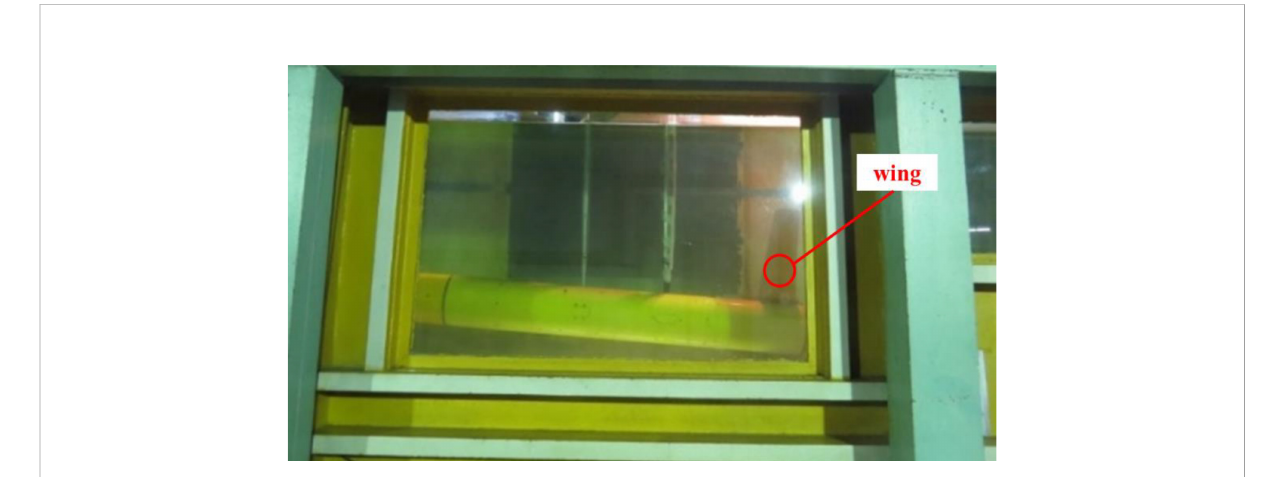
FIGURE 17 Equipment and glider in circulating fl ume